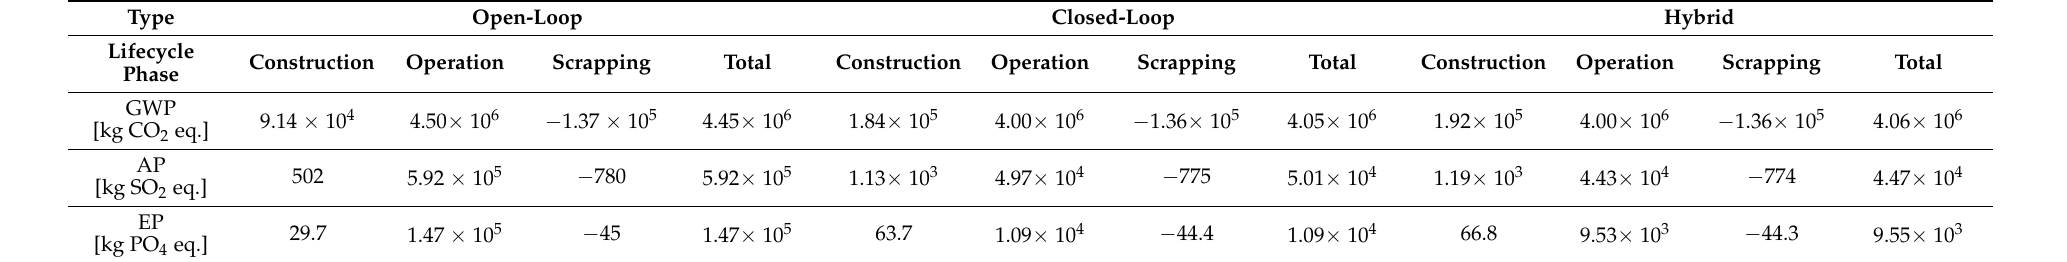
Table 7. Summary of LCA